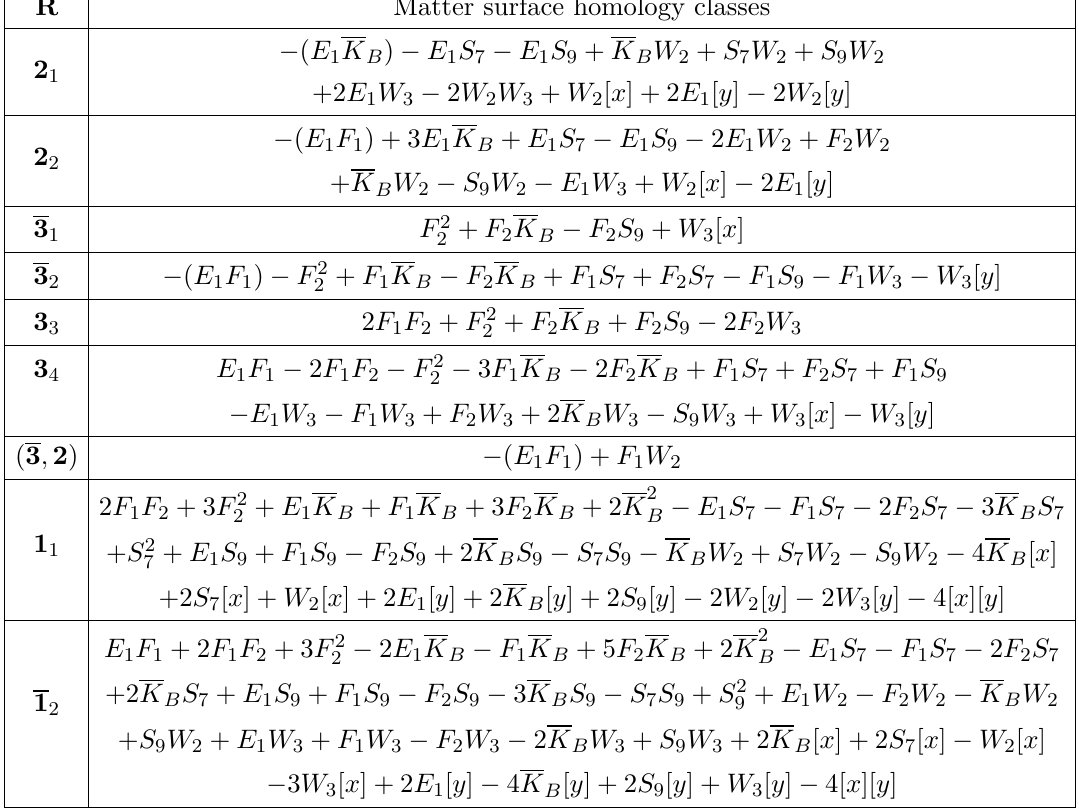
Table 9 . Matter surface homology classes of the second top restricted on the